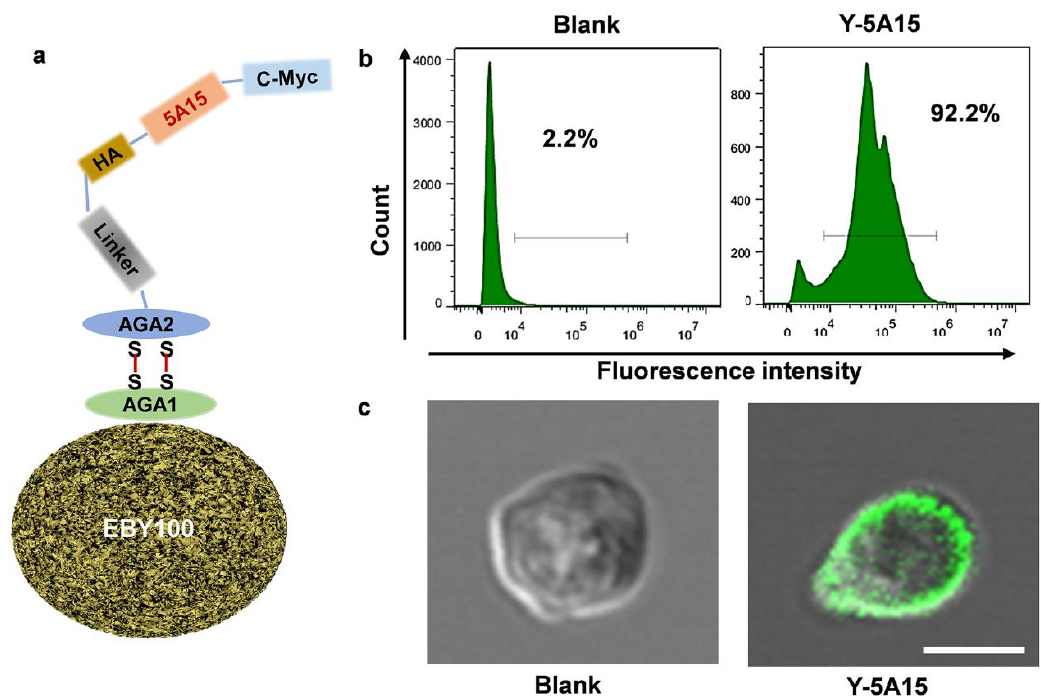
Figure 1. The construction and characterization of the A β 1-15 epitope on the EBY-100 yeast cell wall surface. ( a ) Schematic illustration of the construction of yeast-based vaccine. The epitope antigen with c-myc were displayed on the surface of cell wall by AGA2 interaction with AGA1. ( b ) The 5 × A β 1–15 epitopes expressed on the surface the EBY100 yeast cells were testified by flow cytometry using anti-c-Myc antibody and FITC-labeled secondary antibody. EBY100 yeast cells were used as a negative control. ( c ) The 5 × A β 1–15 epitopes in ( b ) were determined by confocal microscopy. Bar indicates 2 μm.